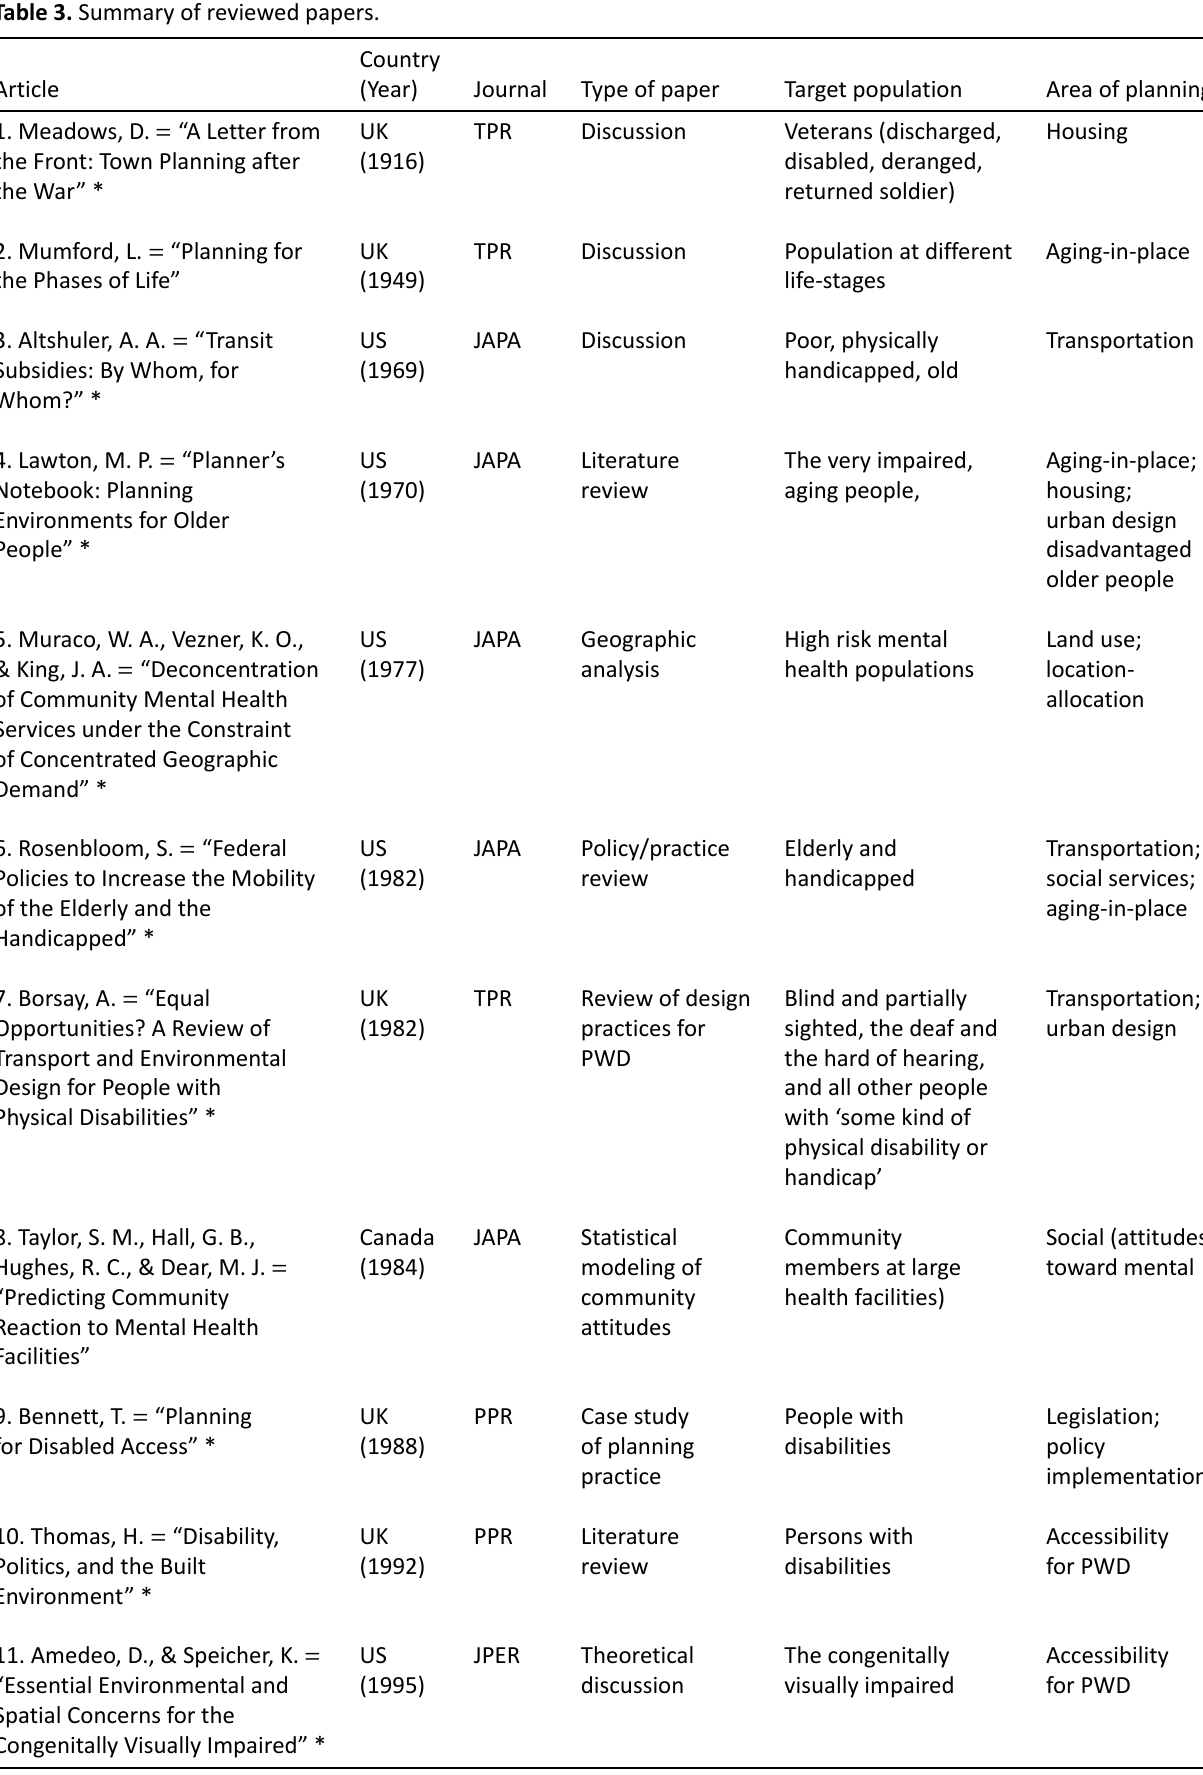
Table 3. Summary of reviewed